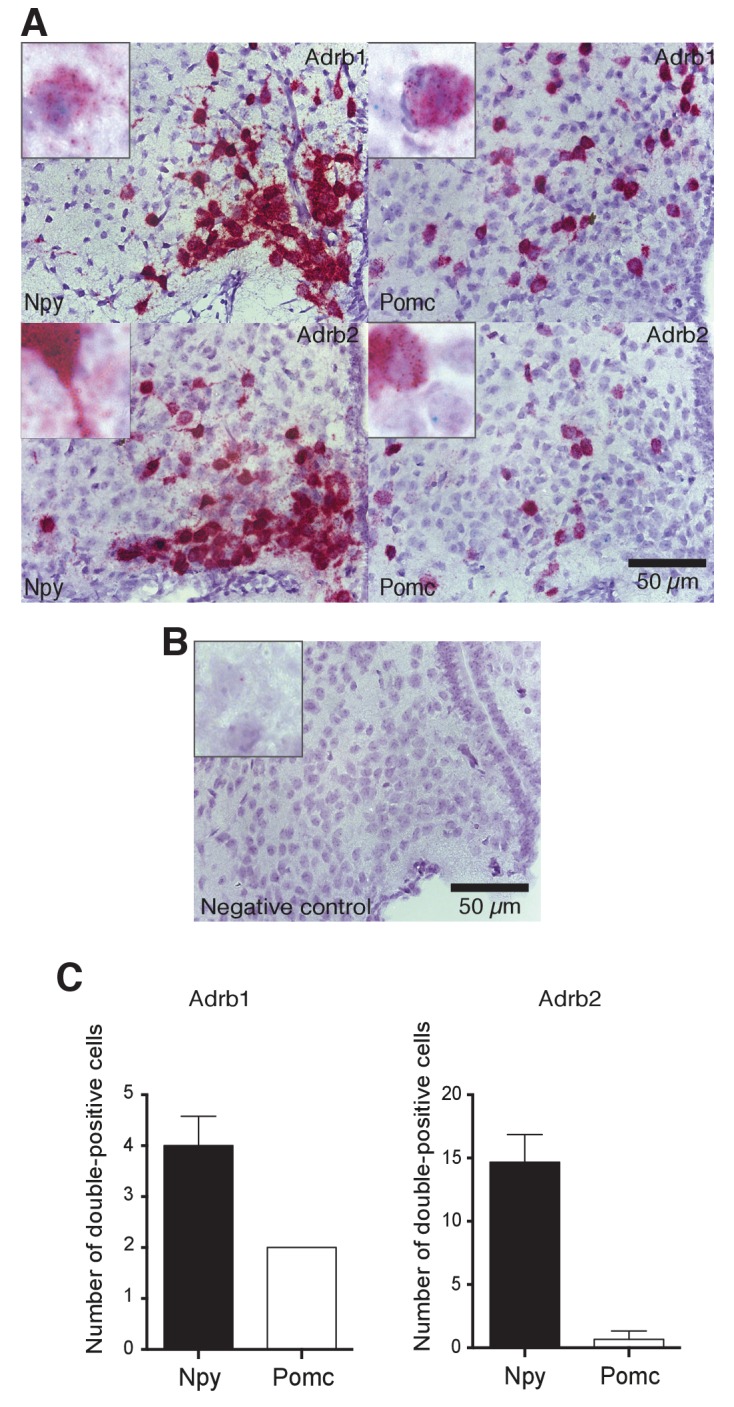
Images (A,B) and quantification (C) of RNA in situ hybridizations against Adrb1 (upper panels, green dots) and Adrb2 (lower panels, green dots) in Npy- and Pomc- expressing (red) neurons.Higher magnification indexes are representative of doubly-labeled cells. Negative control: probe against E. coli gene DapB.